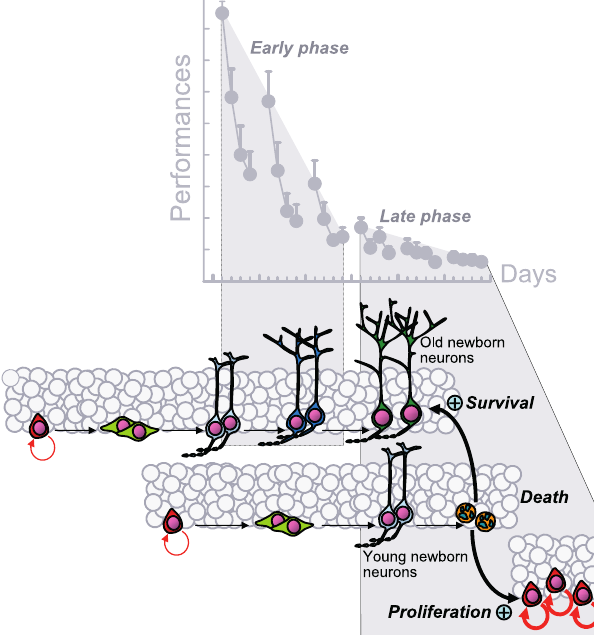
Figure 8. Spatial Learning Depends upon a Selective Stabilization Process Where the Production of New Neurons Is Followed by an Active and Selective Removal of